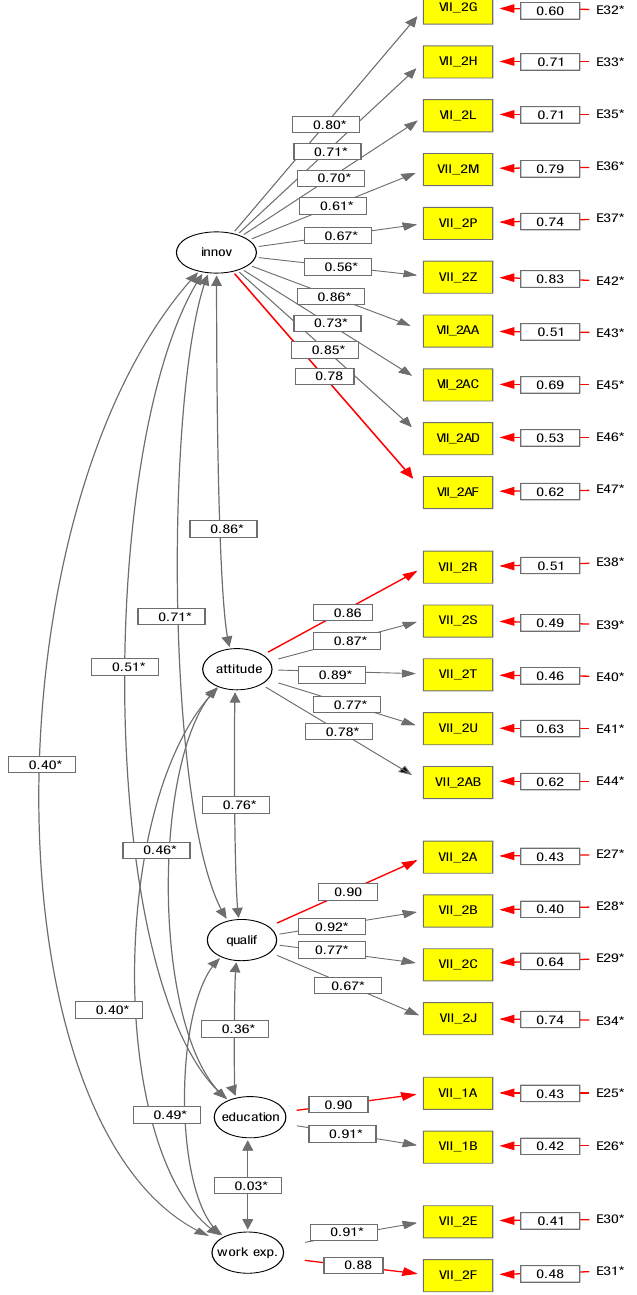
Fig. 2. Employees’ knowledge construct (Standardised coefficients) Notes: CFI = 0.97; NFI = 0.92; SRMR = 0.40; RMSEA = 0.06; Cronbach alfa = 0.91; RHO = 0.97. The correlations among factors are indicated in Table